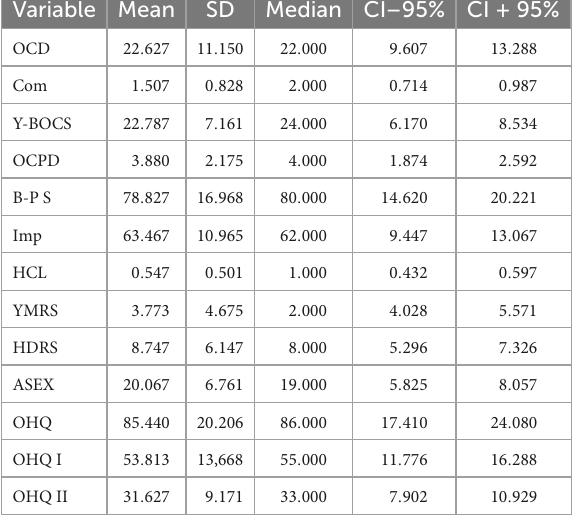
TABLE 2 Descriptive statistics of variables in the obsessive-compulsive disorder (OCD)